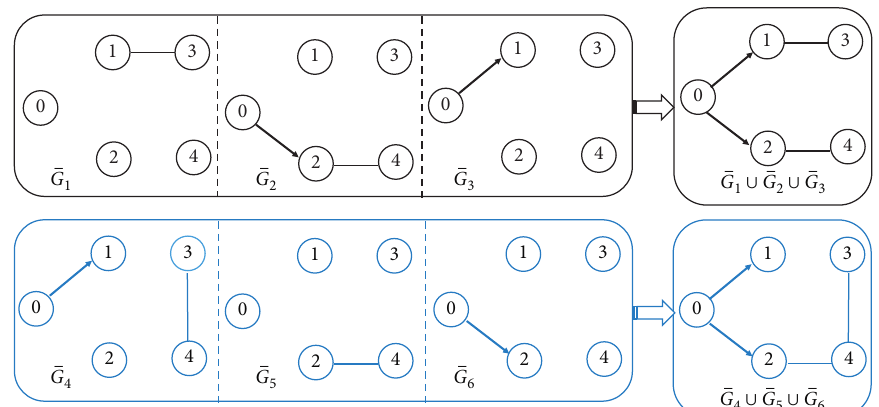
Figure 3: The communication topologies between UUV leader and UUV followers.